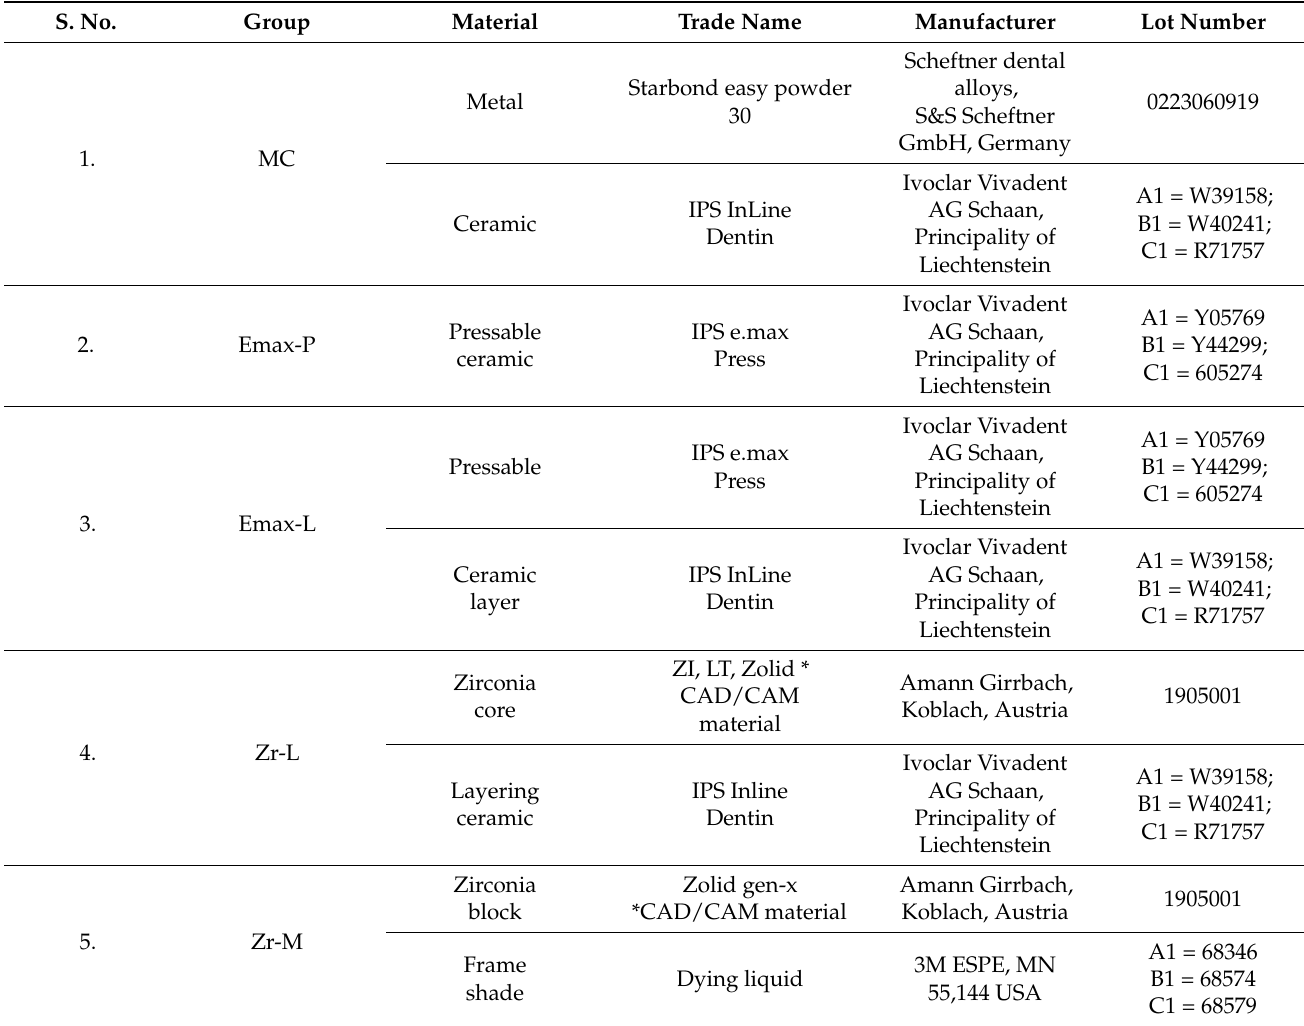
Table 1. Details of the materials used in the research